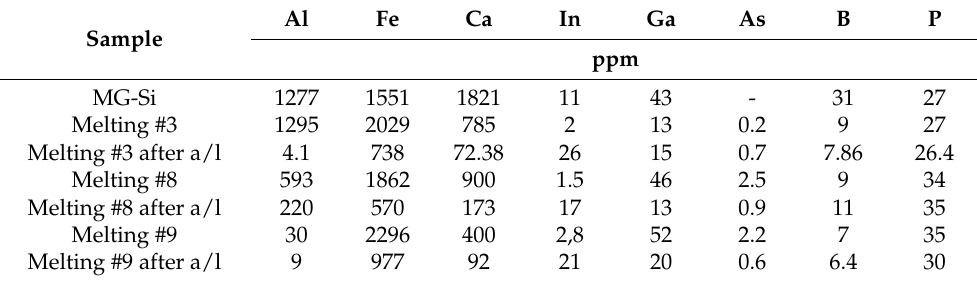
Table 3. Impurity composition of MG-Si and purified Si after slag refining and after acid leaching